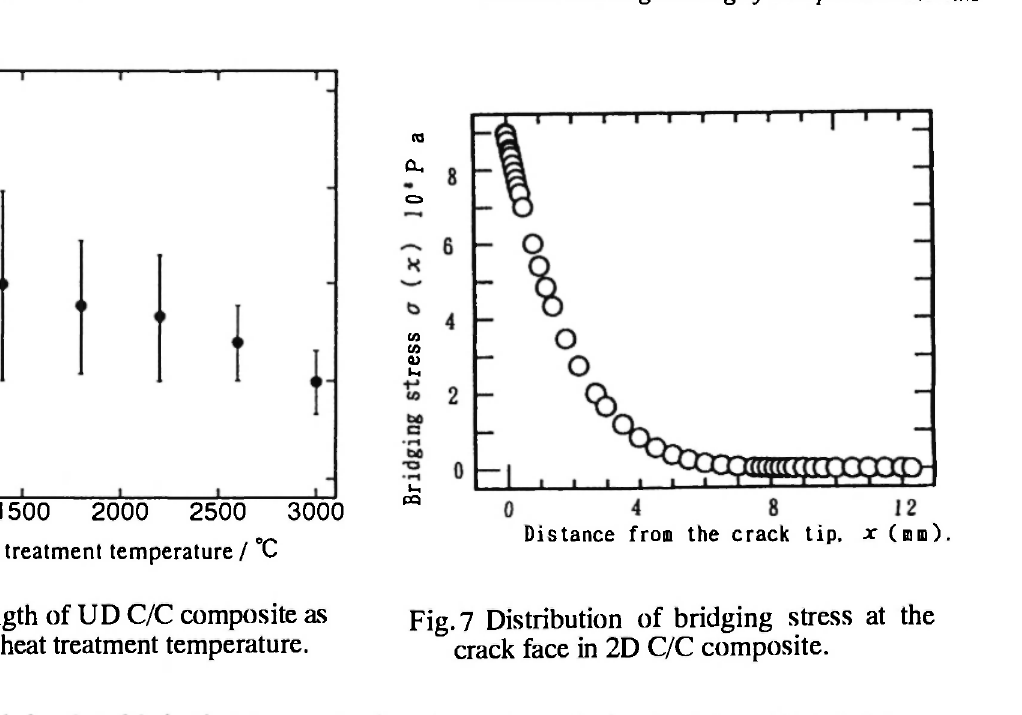
Fig. 7 Distribution of bridging stress at the crack face in 2D C/C composite.